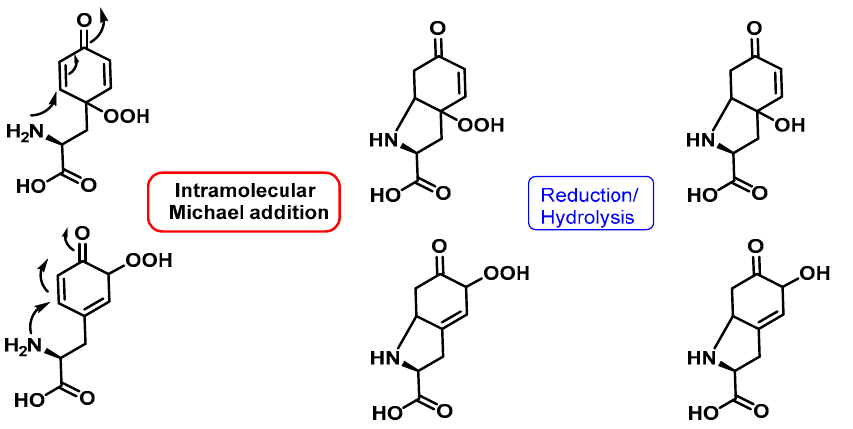
Figure 54. When tyrosine is N-terminal, the major products are hydroperoxides that have cyclized via intramolecular Michael addition of the terminal amine.